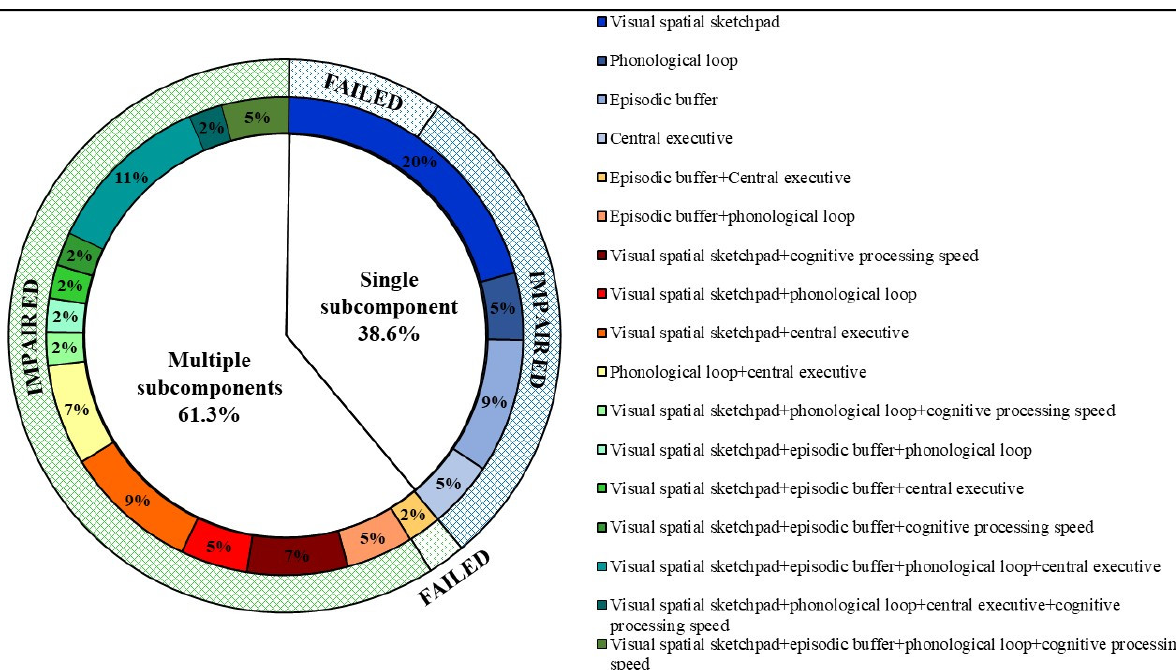
Table 3. Diagnostic accuracy of different WM test combinations.